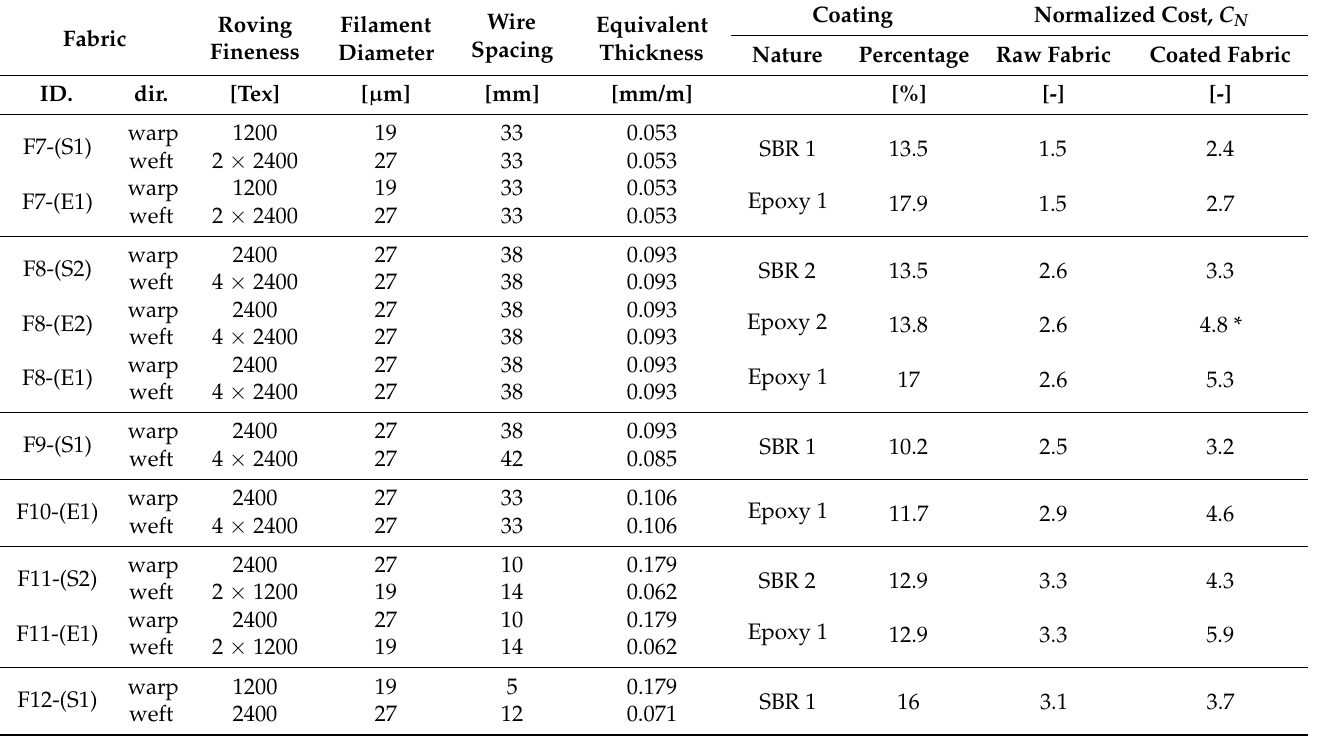
Table 2. AR-glass fabric properties and costs (part 2, equivalent thickness in the warp direction higher than 0.05 mm/m).